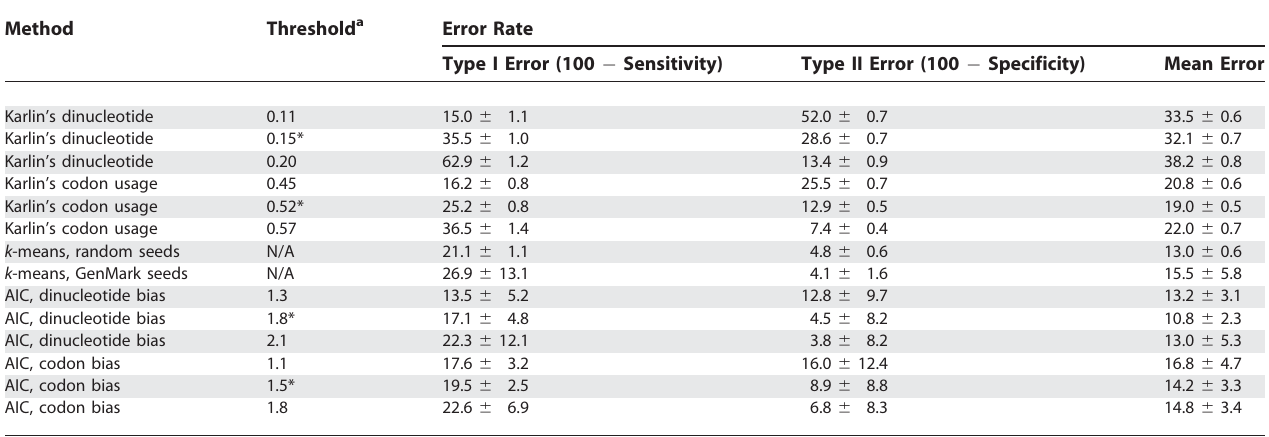
Table 2. Error Rates of Parametric Methods for Detecting Atypical Genes in an Artificial E. coli Genome